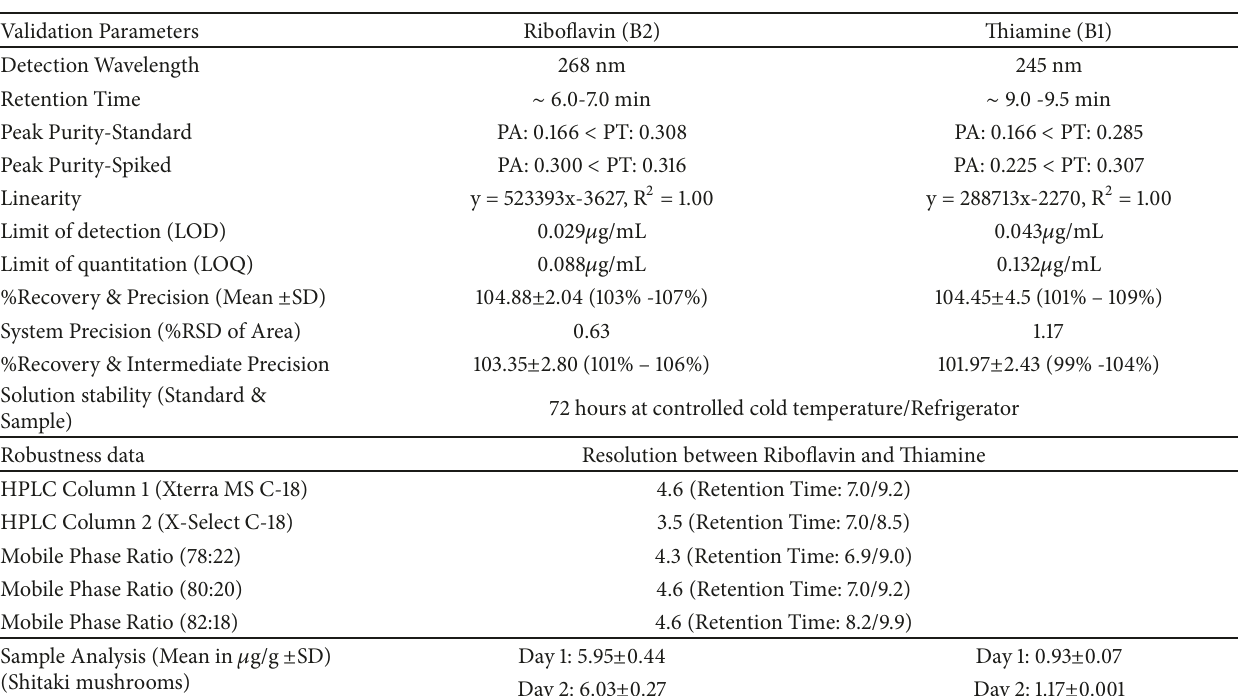
Table 1: Method validation